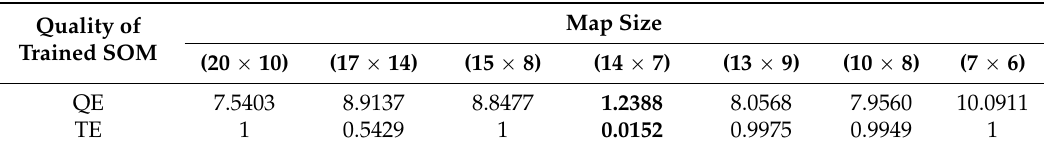
Table 5. QEs and TEs of different map